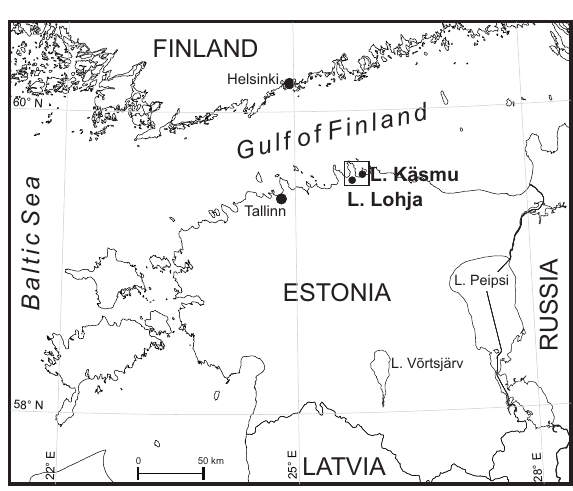
Fig. 1. Location of the study area, marked by a